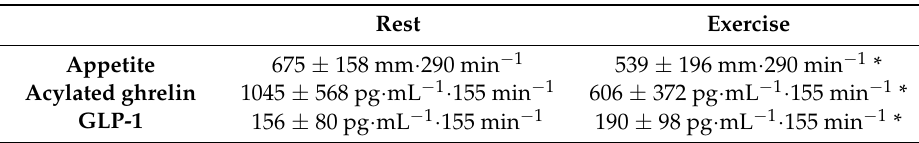
Figure 1. Mean appetite scores ( a ) for REST ( ● , solid line) and EX ( ○ , dashed line). Solid block represents exercise. Stripe block represents the ad libitum test meal. * on x axis labels indicates min post ‐ exercise. Values are mean ± SEM. * = exercise significantly different to rest, p < 0.05. Individual appetite responses immediately post exercise ( b ) are also shown for EX. The dashed line represents the mean response. Table 2. Area-under-the-curve values for subjective appetite and plasma concentrations of acylated ghrelin and